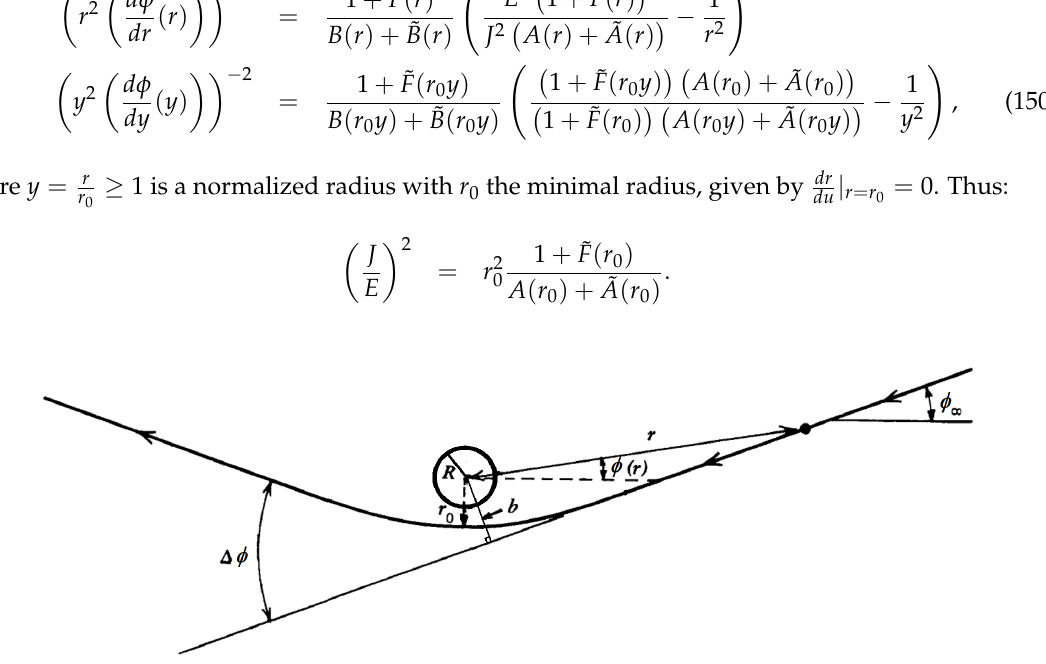
Figure 5. Trajectory by gravitational lensing. R is the radius of the star, r 0 is the minimal distance to the star, b is the impact parameter, φ ∞ is the incident direction and ∆ φ is the deflection of